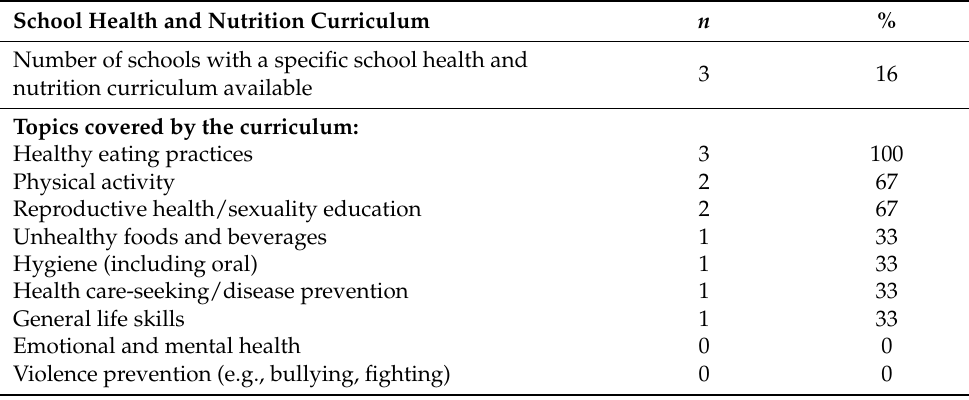
Table 2. Availability of school health and nutrition curricula as reported by the school administrators from 19 junior secondary schools in